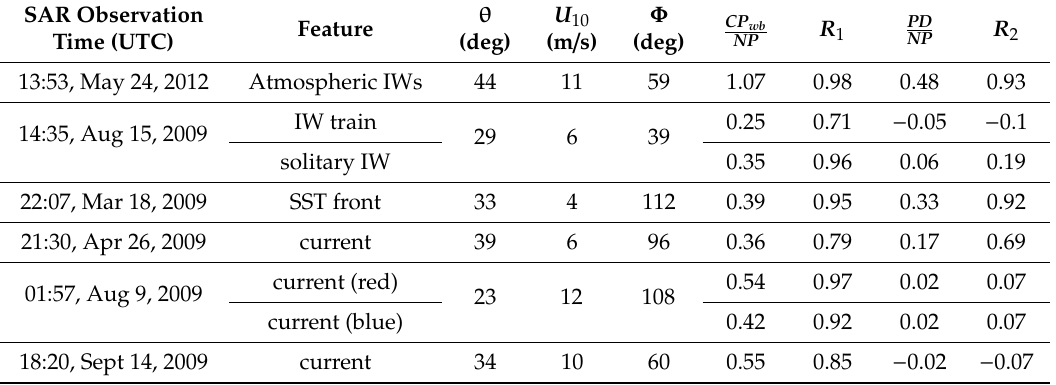
Note: Φ is radar look direction relative to the wind direction, R 1 and R 2 are correlation coe ffi cients between CP wb and NP , and PD and NP , respectively. θ , U 10 , and φ are radar incidence angle, wind speed at 10-m height and the angle between radar look direction and wind